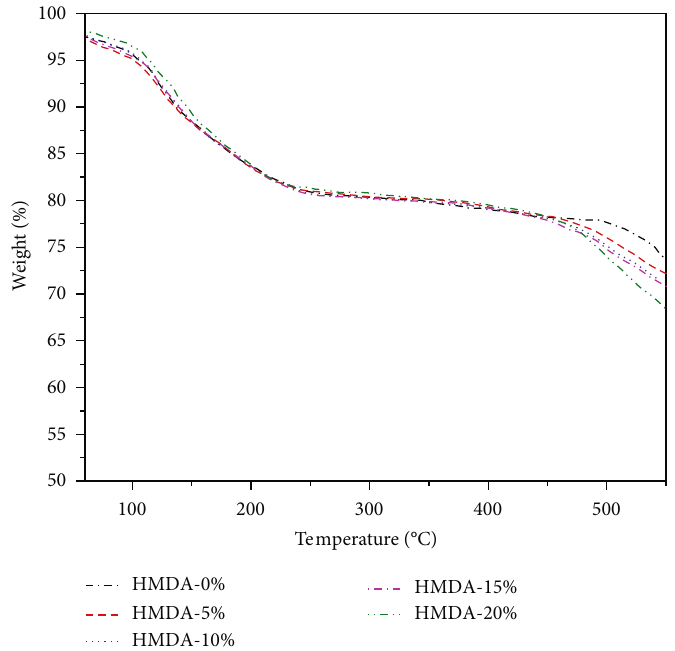
Figure 4: Weight loss (%) during forming and imidization with increasing temperature.